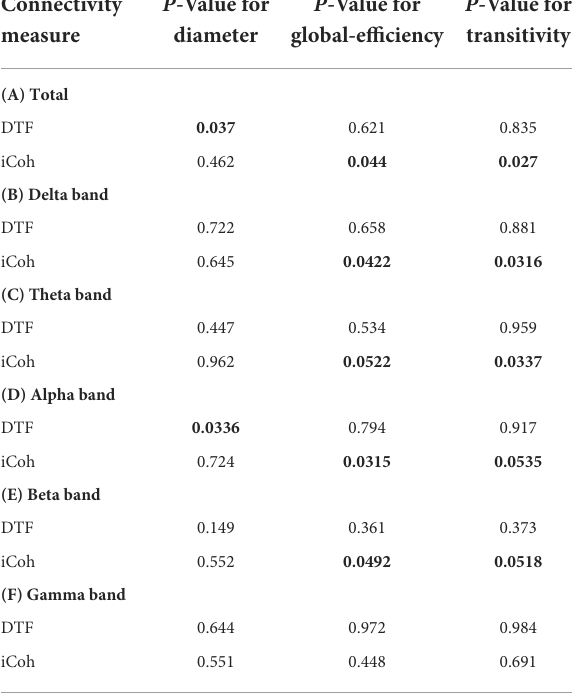
TABLE 5 The p -value results of the Wilcoxon rank-sum test after comparing the graph features of calculated brain networks. P -Value for Connectivity measure diameter